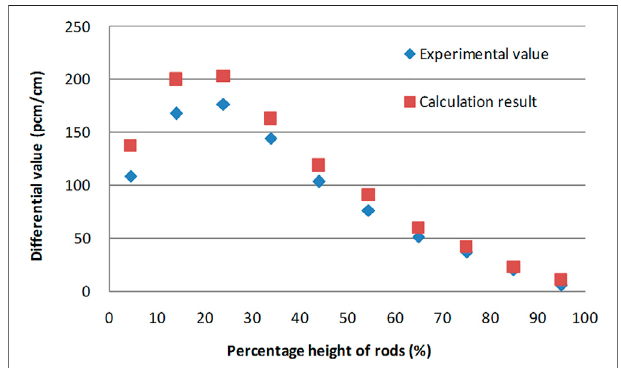
FIGURE 13 | Differential value curve of B rod group (Scheme 8).